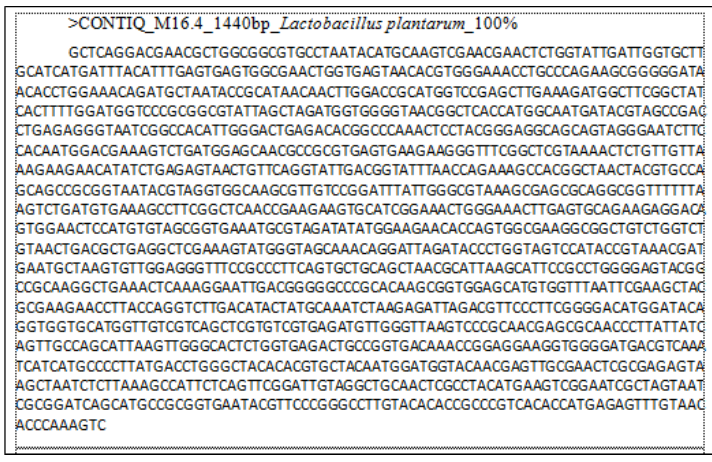
Figure 3. Lactid acid bacteria gene sequence from isolation of Lactobacillus plantarum .